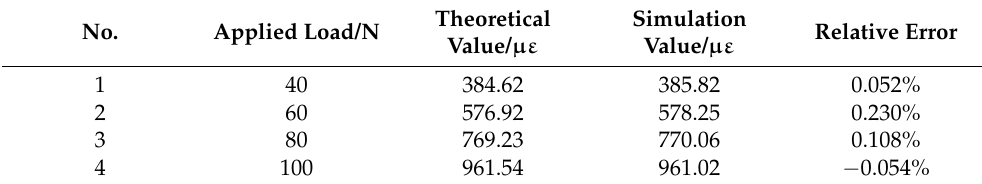
Table 3. Comparison of simulated and theoretical values with different loads. Theoretical No. Applied Load/N Value/ µε